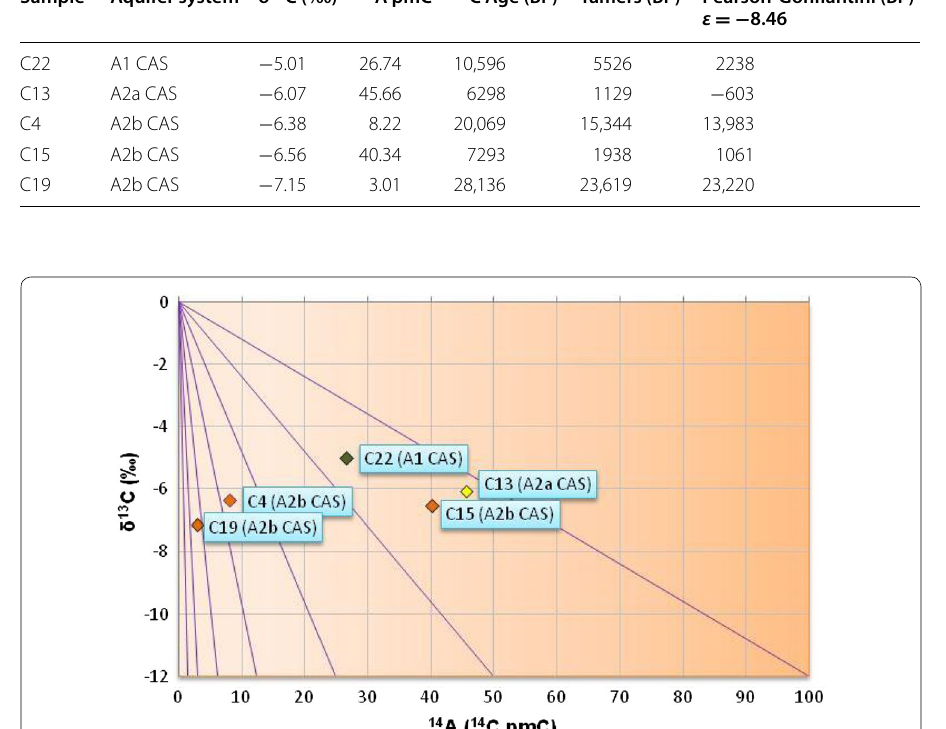
Fig. 8 14 C isochrones for study area